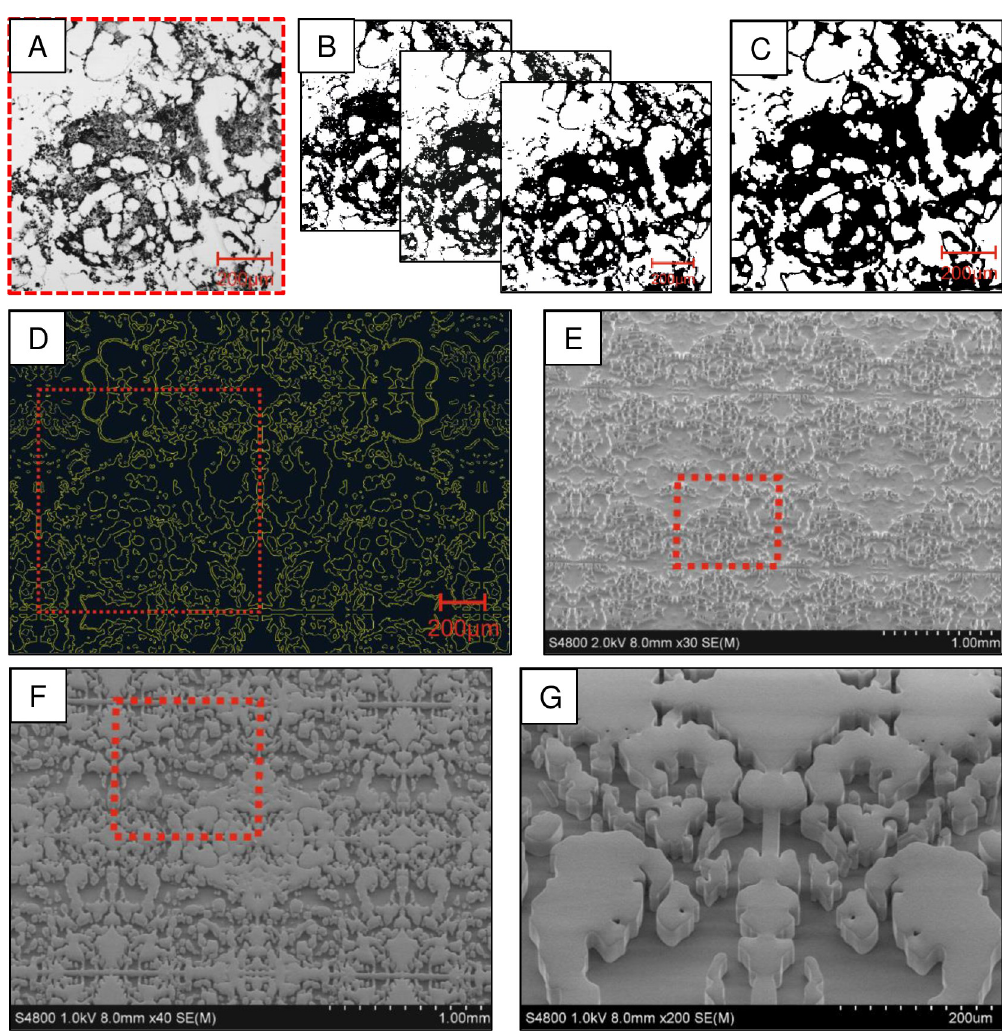
Fig 2. Processing steps to generate a 3D structure mimicking the human HSC niche. (A) The biopsy of the bone marrow (BM) from a human long bone cross section was imaged by laser scanning microscopy. (B) Image processing was done by using edge and threshold algorithms to generation the final vector image for mask translation (C). (D) This vector image was further converted into a photolithographic mask to generate a casting mold through dry etching of a silicon wafer (E). (F-G) Polydimethylsiloxane (PDMS) was casted into the silicon mold to generate 3D PDMS structures. Red squares indicate the initial structural element which was obtained from the BM biopsy.